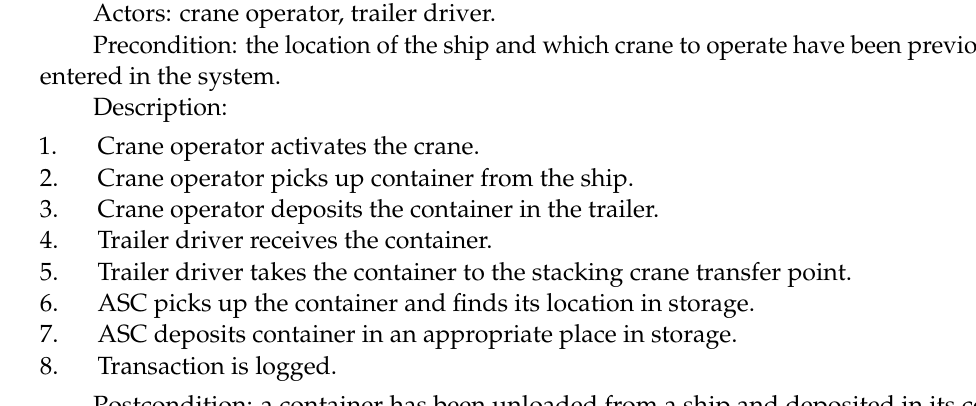
Figure 9. Activity diagram for UCs unload container and move to Storage.